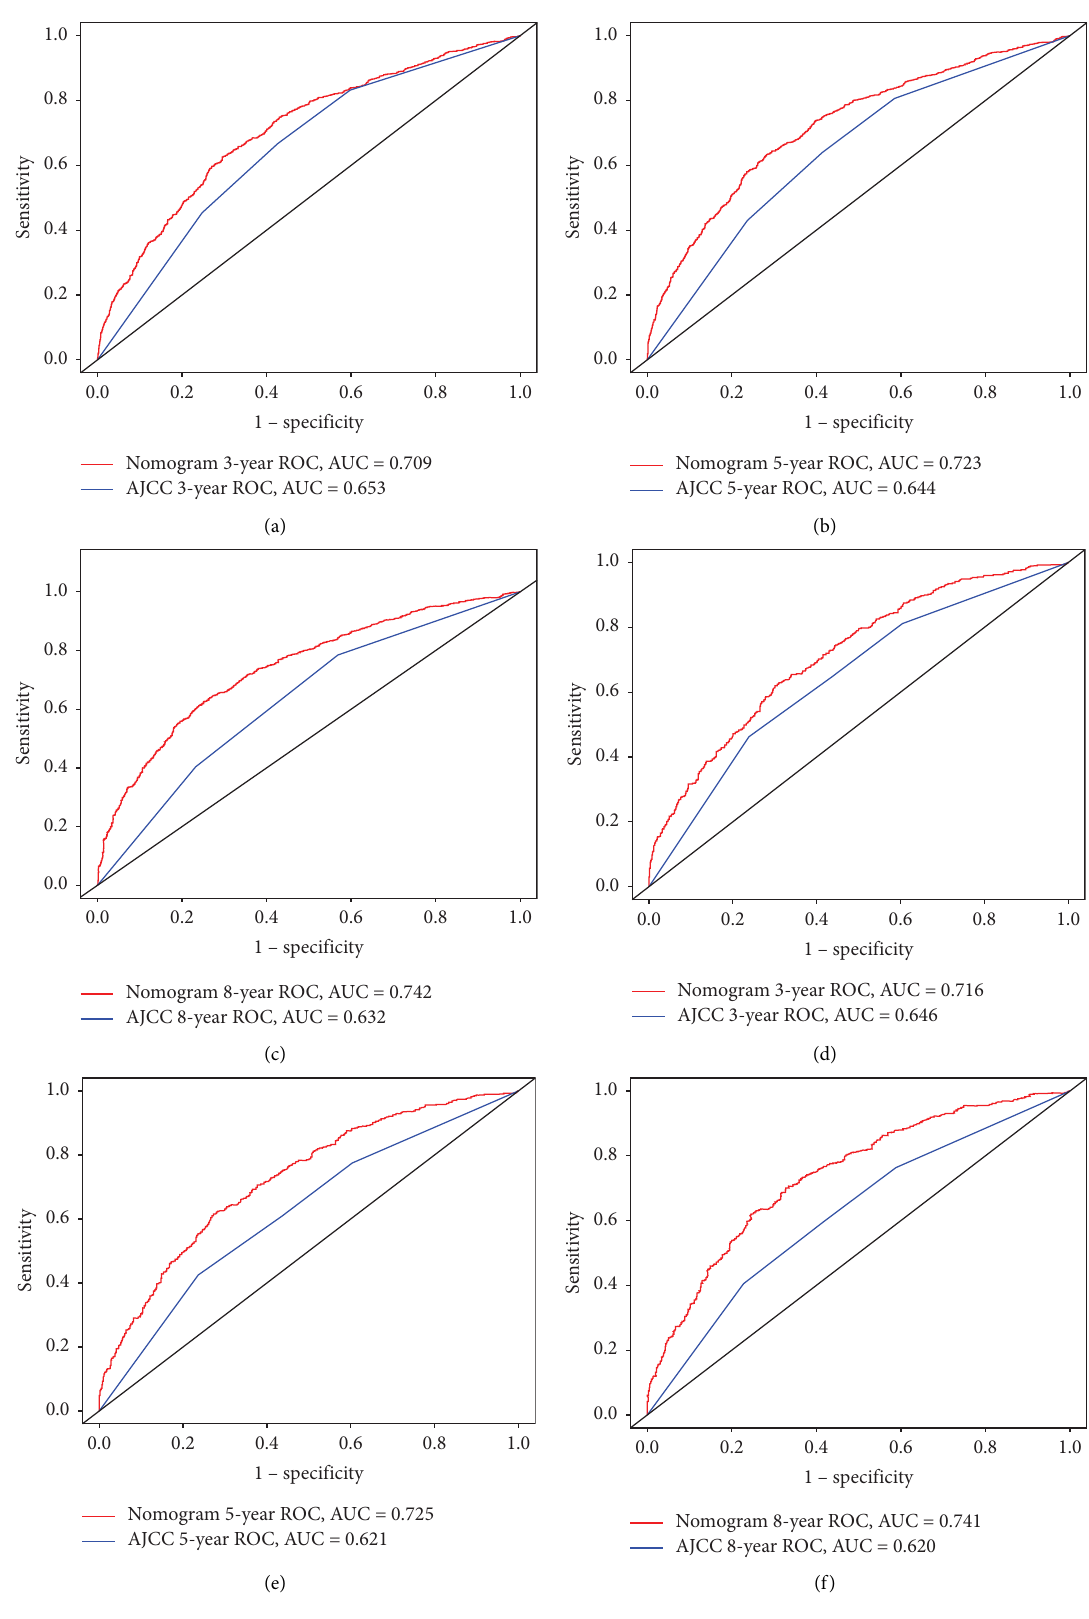
Figure 3: ROC curves. Te area under the ROC curve (AUC) of the new nomogram and AJCC. Both training cohort (a–c) and validation cohort (d–f) show that the new nomogram predictive ability is better than that of